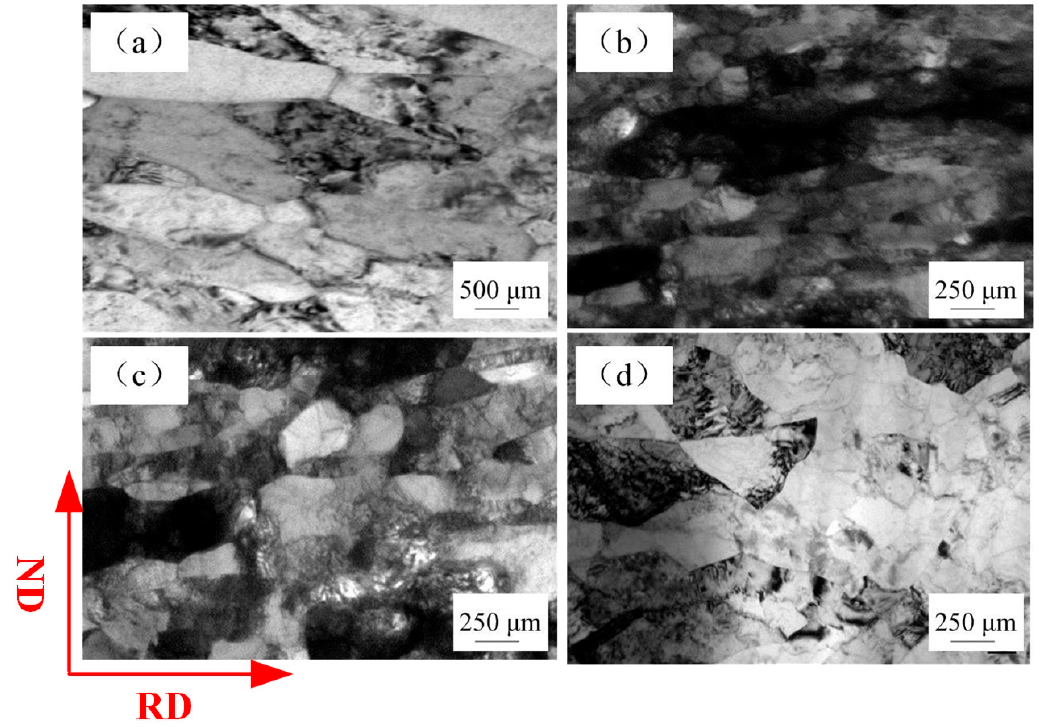
Figure 10. Transmission electron microscopy (TEM) images of the copper samples with different thicknesses. ( a ) 600 µm, ( b ) 80 µm, ( c ) 40 µm, ( d ) 20 µm.